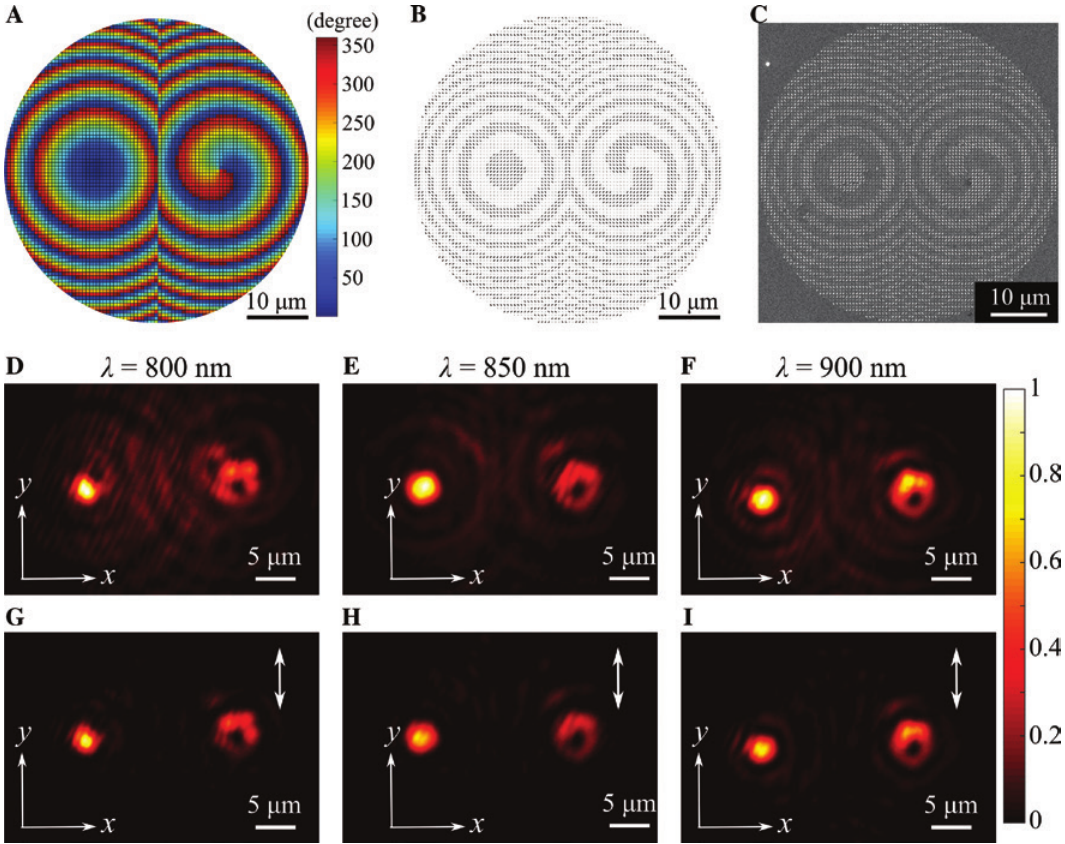
Figure 5: Design, fabrication, and experimental demonstration of the dual-focal metasurface. (A) Calculated phase profile, (B) designed pattern, and (C) SEM image of the dual-focal metasurface that simultaneously generates dual-focal spots with different intensity profiles for the cross-polarized reflected light, where the left sub-metasurface is to create the convention focused Gaussian beam and the right sub-metasurface is responsible for generating a focused vortex beam. The dual-focal metasurface has a diameter of D = 50 μ m, a focal length of f = 60 μ m, the topological charge of l = 1, and the distance between two foci of s = 20 μ m. (D–F) Measured intensity profiles at the corresponding focal planes of different wavelengths without polarization analyzer. (G–I) Measured intensity profiles at the corresponding focal planes of different wavelengths when a linear polarizer oriented 90 ° with respect to the illumination polarization was placed in front of the camera. In (D–I), an x -polarized Gaussian beam is impinging on the sample at normal